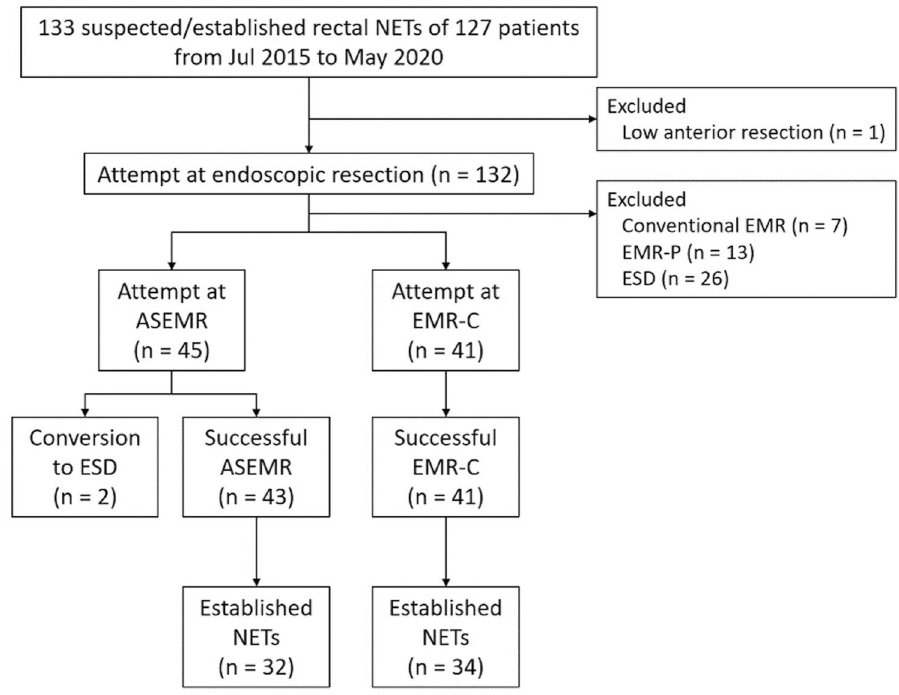
Figure 1. Flow chart of patient throughput. NET neuroendocrine tumor, EMR endoscopic mucosal resection, EMR-P EMR with circumferential precutting, ESD endoscopic submucosal dissection, ASEMR anchored snare- tip EMR, EMR-C cap-assisted